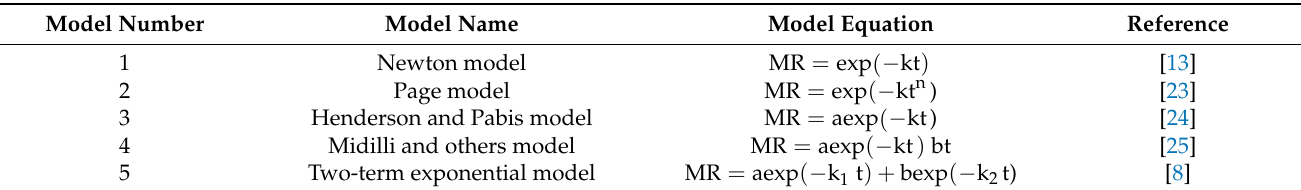
Table 1. Thin-layer empirical models applied to SMIR drying